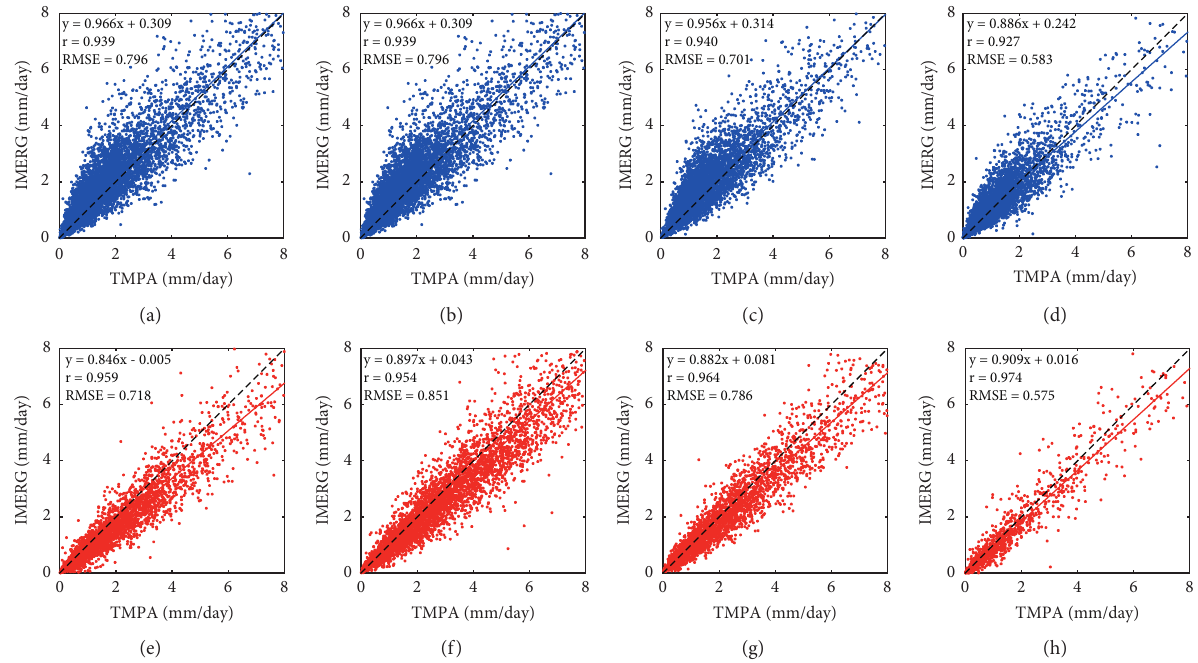
Figure 7: Scatter plots of the amplitude of the diurnal harmonics in the IMERG V06B and TMPA 3B42 products over ocean (blue) and land (red) using a 1 ° × 1 ° grids for (a, e) spring; (b, f) summer; (c, g) autumn; and (d, h) winter. The black dashed line indicates a one-to-one